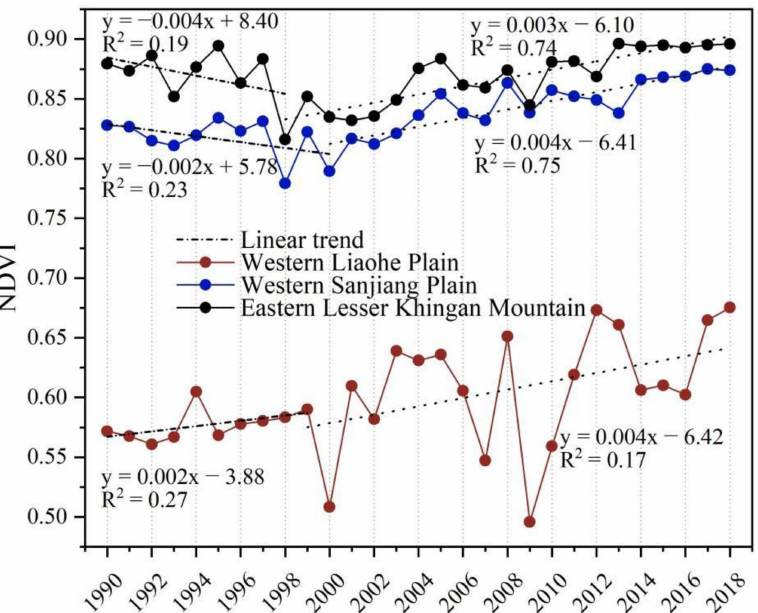
Figure 13. Annual mean Normalized Difference Vegetation Index (NDVI) of the areas where the SPEI12 trend turned during the period